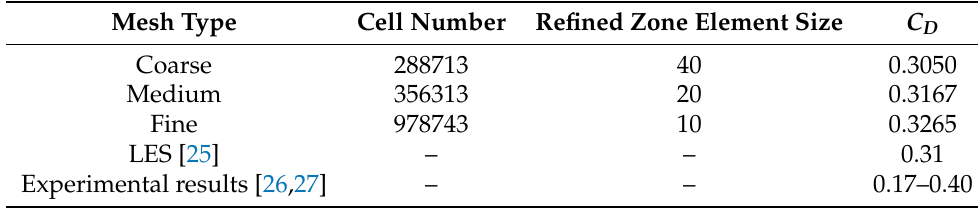
Table 1. Mesh verification for different mesh